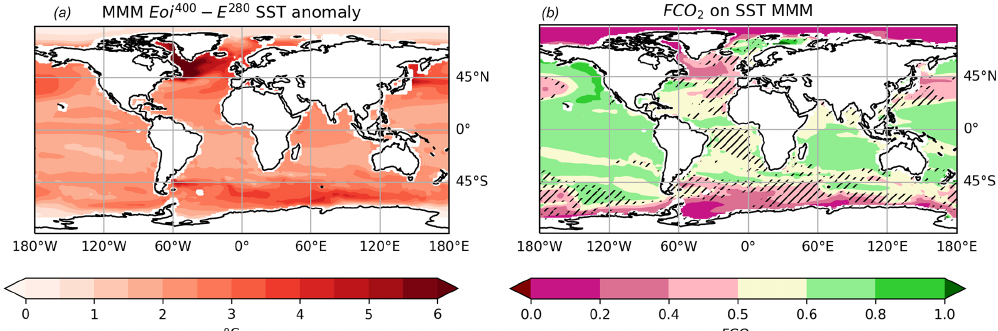
Figure 5. MMM Eoi 400 minus E 280 SST anomaly (a) and FCO 2 of the MMM for SST (b) . IPSLCM5A2 is excluded from SST analysis due to limited data availability. The hatching in (b) represents where there is no consistent agreement between models on whether CO 2 forcing or non-CO 2 forcing is the most important (i.e. whether FCO 2 > 0 . 5 or FCO 2 < 0 .